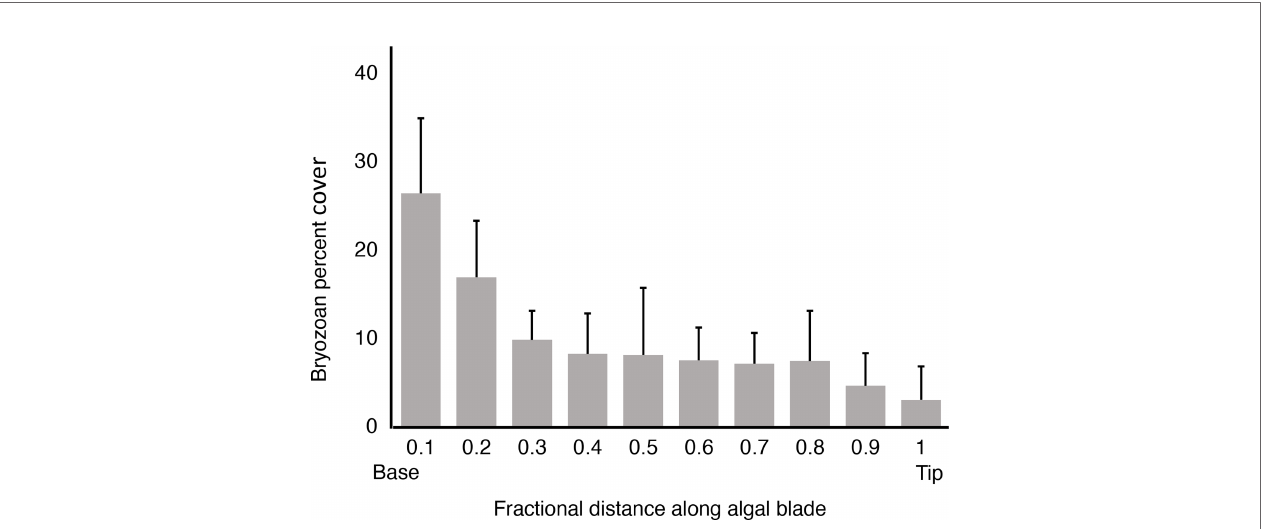
FIGURE 3 | Percent of the area of an algal blade covered by M. membranacea , plotted as a function of fractional distance along an algal blade ([distance from base of blade]/[total blade length]). Means for ten M. splendens from the protected site are plotted, and error bars represent one standard deviation. There is a signi fi cant negative association between % cover of bryozoans and distance from the base of an algal blade (p < 0.01, one-tailed Kendall ’ s tau rank correlation